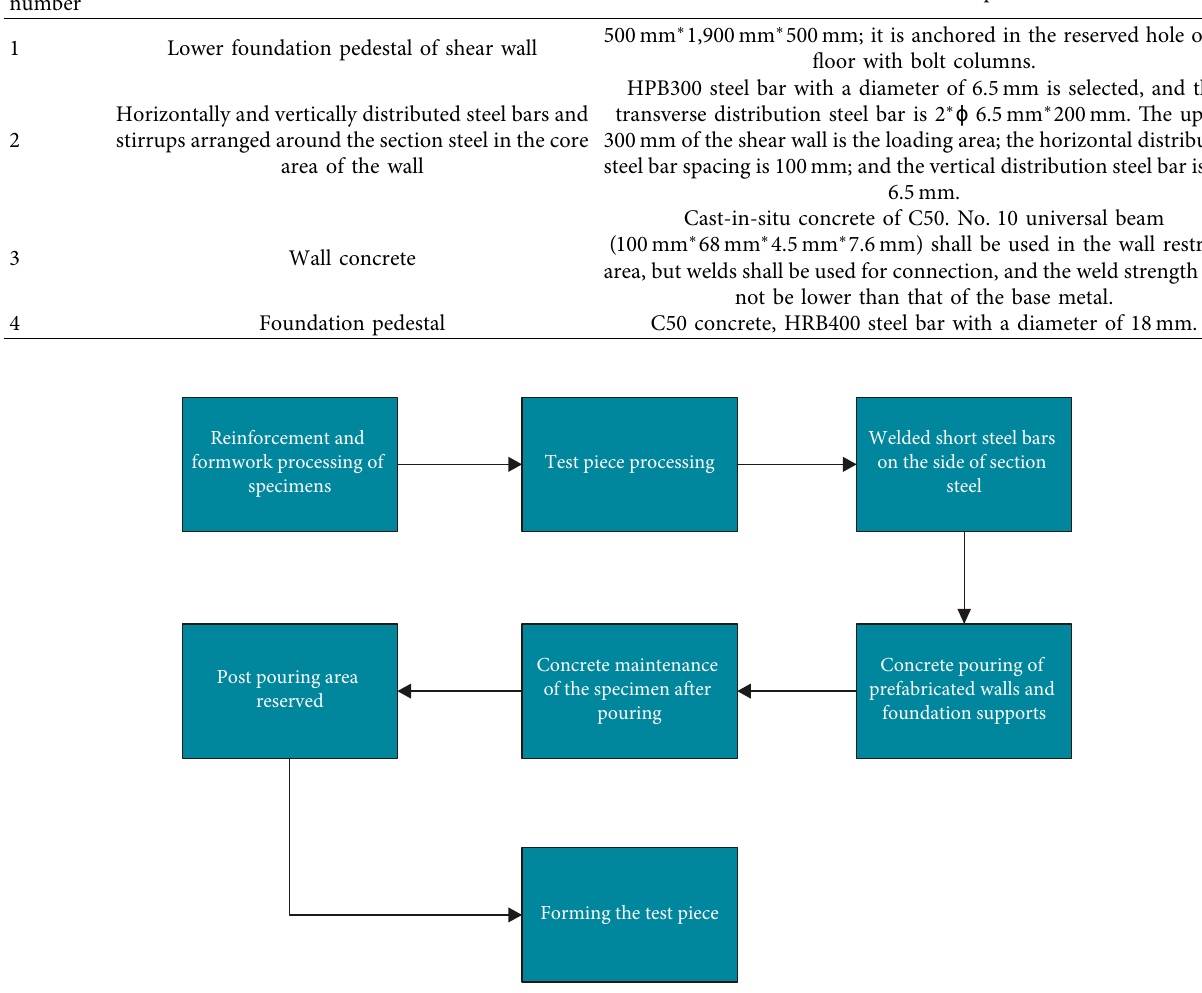
Figure 5: Production flow chart of the test piece.